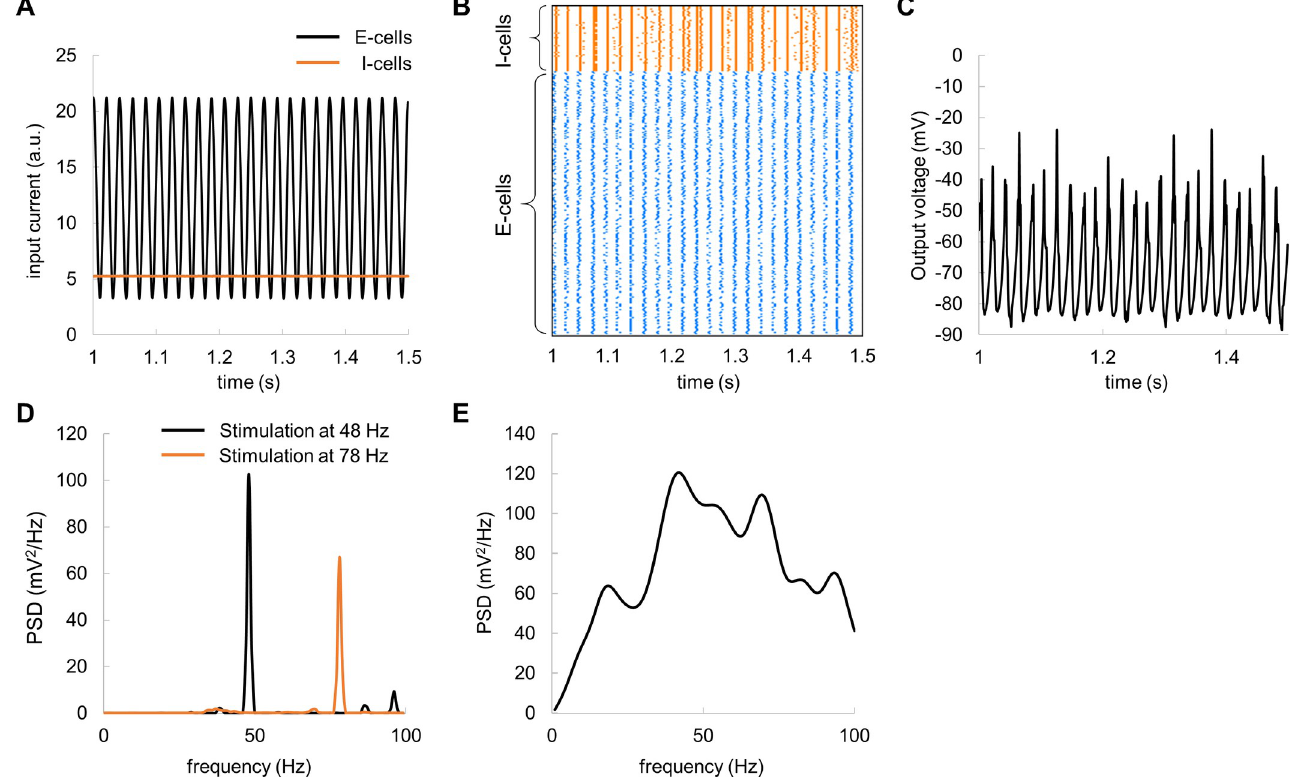
Fig 10. Oscillatory input current reveals an amplification of oscillatory dynamics at the ~48 Hz resonance frequency. (A) Oscillatory input current to E-cells (black line) and constant current to I-cells (orange line). (B) Spike rastergram for E-cells and I-cells. (C) The average membrane potential of the E-cells. (D) Example of power spectral density for input current at 48 Hz (resonance frequency, black line) and at 78 Hz (non-resonance, orange line). (E) Power spectral density of the average membrane potential for oscillatory input over multiple frequencies, 1–100 Hz, and amplitude of 9 μ A.